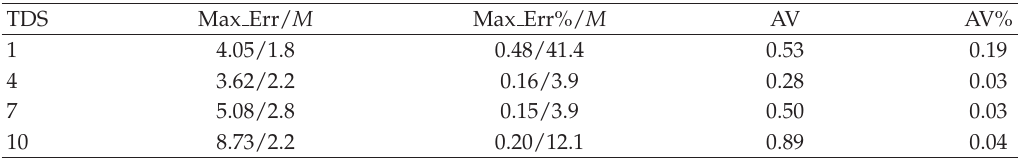
Figure 3: The actual characteristic curves and the curves fitted by (cid:3) 4.1 (cid:4) for the IAC51 relay. Table 3: Summary of the SVD results for the IAC51